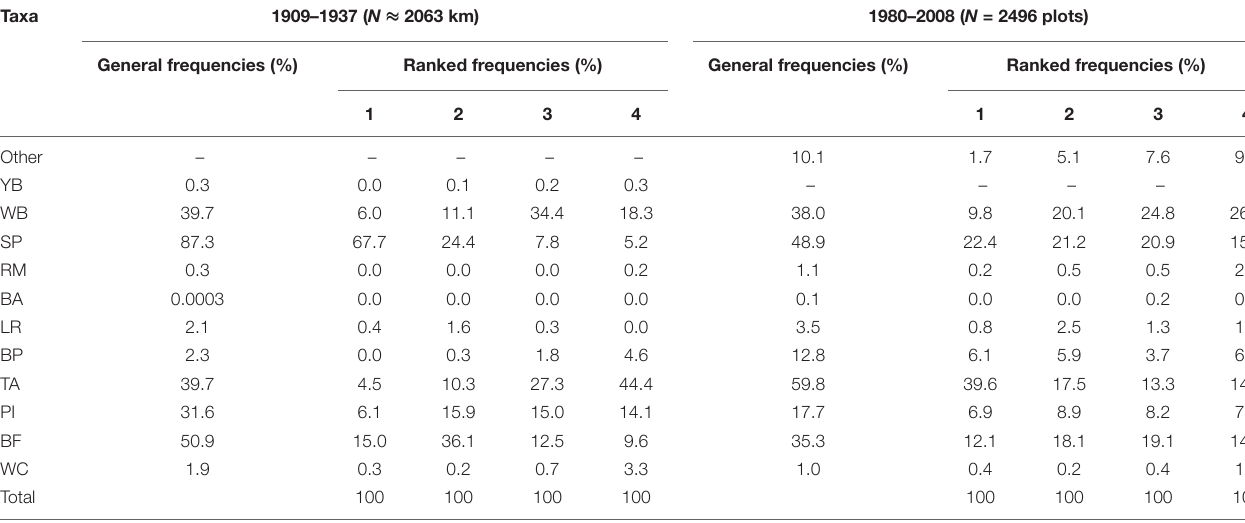
TABLE 1 | General frequencies and ranked frequencies of taxa during pre-settlement (1909–1937) and modern (1980–2008) periods. Taxa